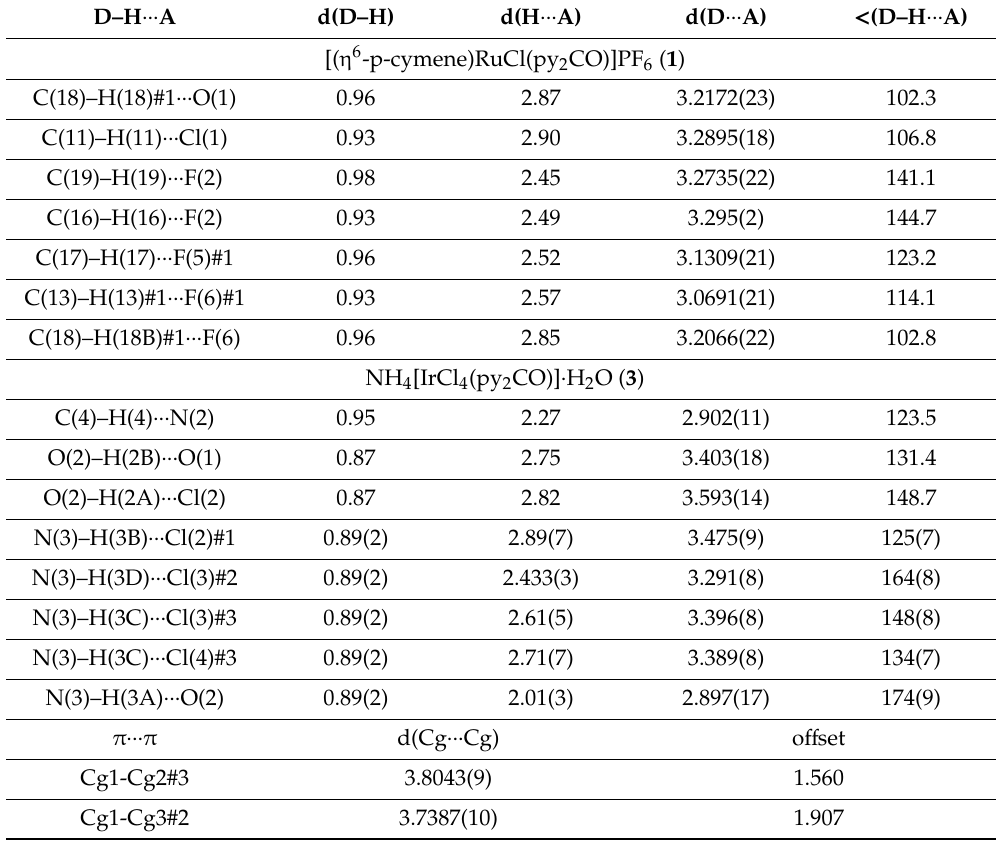
Figure 2. The short contacts for complex 1 ( a ) and ( b ) fragment of the molecular structure of 1 showing the zig-zag motif view the c direction. Table 3. Hydrogen bonds for 1 and 3 [Å and deg.] and π ··· π interactions Table 2. Bond lengths [Å] and angles [deg.] for 1 and 3 .